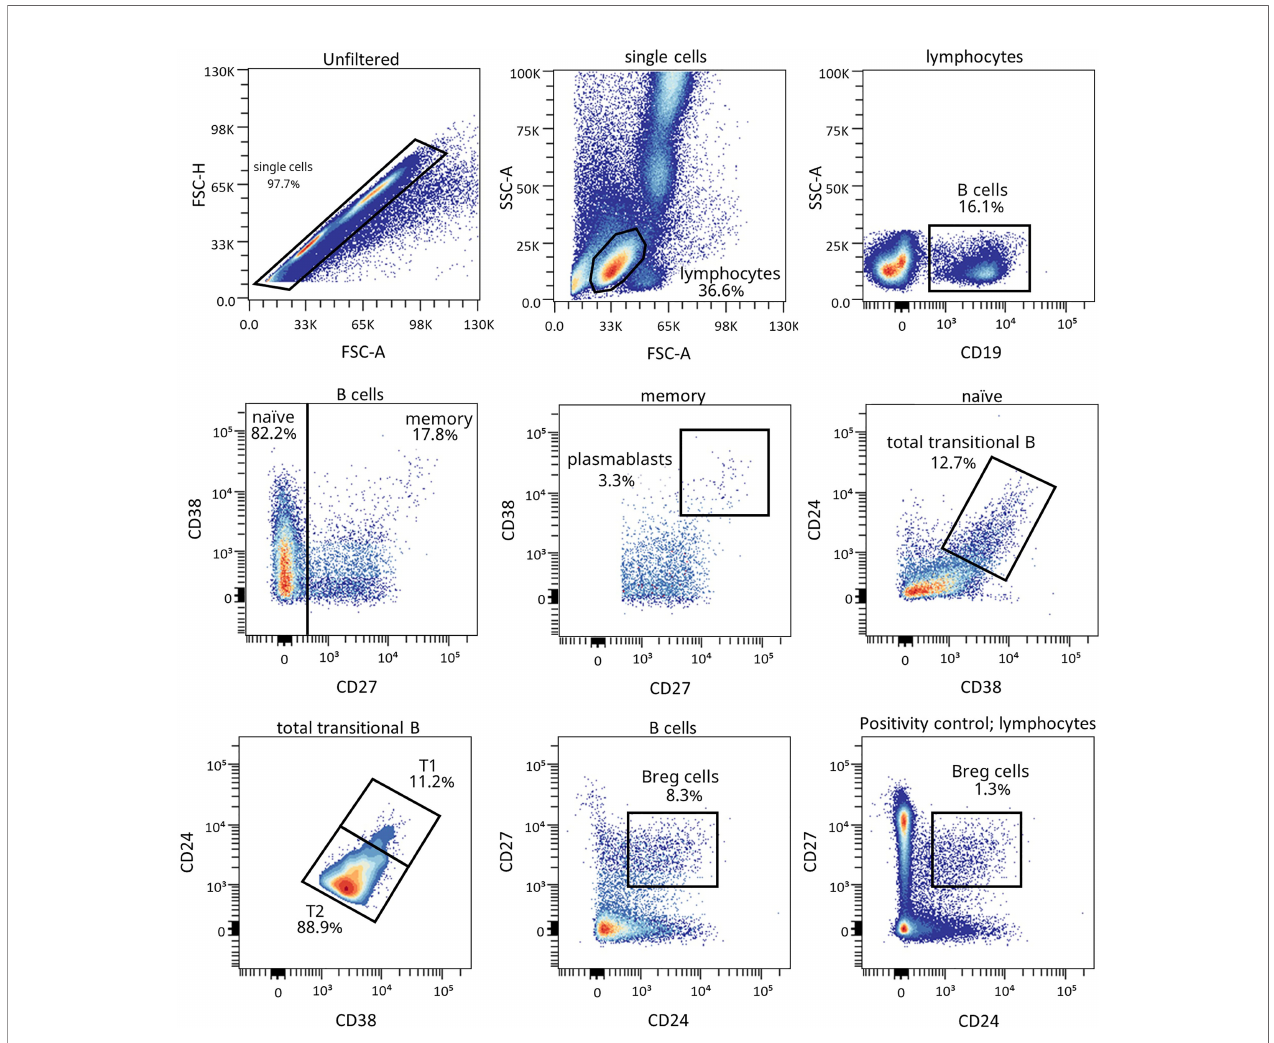
FIGURE 4 | Representative gating strategy for the B cell subpopulations panel. Gating strategy used to analyze the percentages of transitional B cells (total, T1, and T2), B REG and plasmablasts based on the expression of the markers CD19, CD27, CD38, and CD24. Positivity control for CD27 vs CD24 using lymphocytes as an internal reference